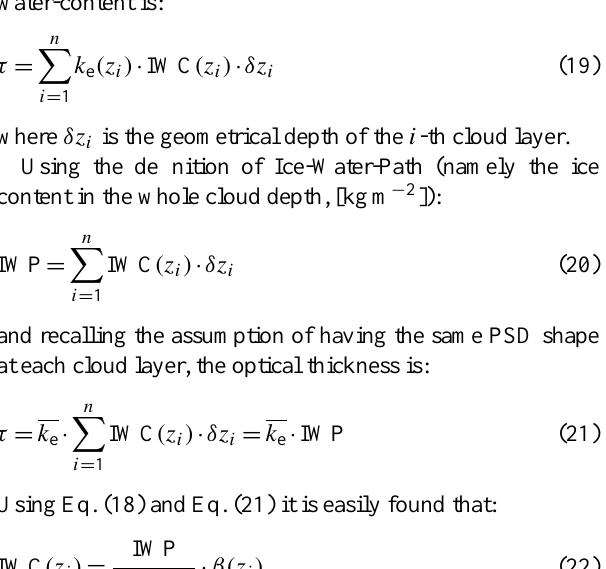
Fig. 10. AIRS brightness temperature differences for pairs of clouds with same OD but IWC profile that in one case is derived from climatological BSPs and in the other case is assumed constant along the cloud vertical. Four different geometrical thicknesses are considered in the example. Typical ODs are associated to each thickness.